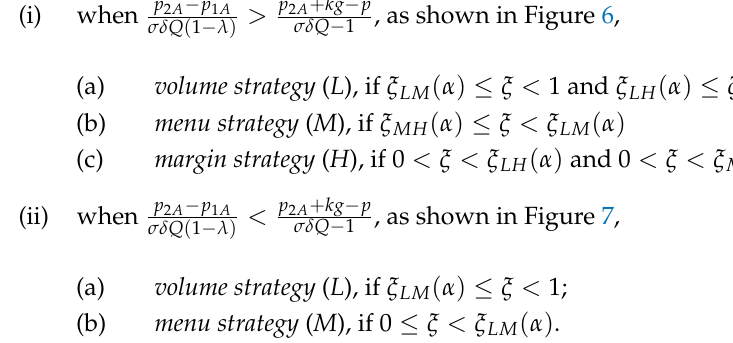
Figure 6. Comparison of the four strategies given δ = 3 when p 2 A − p 1 A